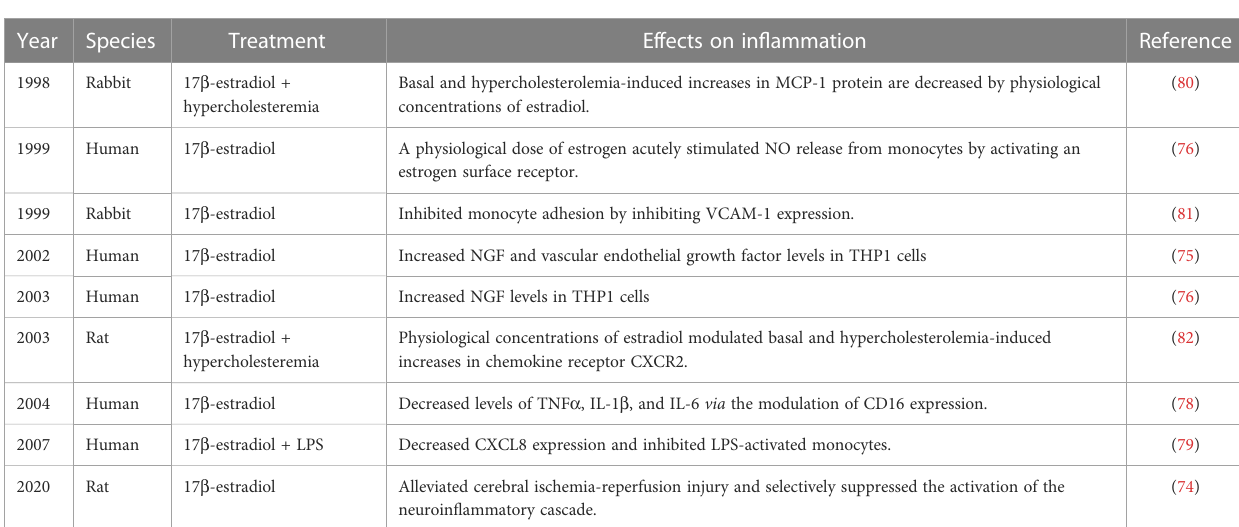
TABLE 2 Anti-in fl ammatory effects of estrogen on